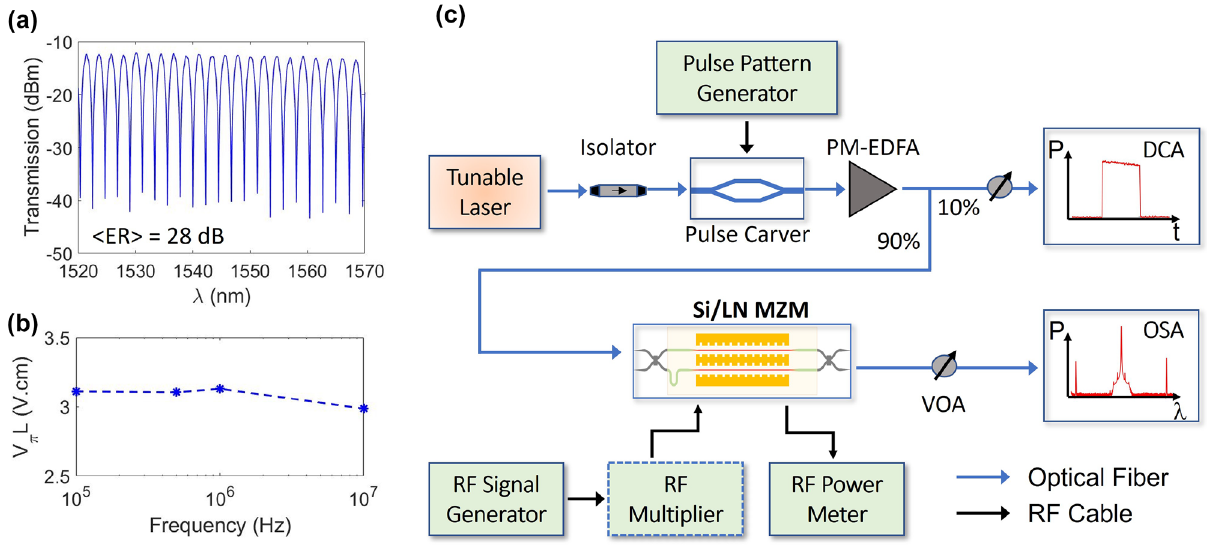
Figure 4. ( a ) The measured optical transmission of the asymmetric hybrid-bonded Si/LN MZM with no modulation signal applied. The asymmetric path-length difference gives an FSR of 2.3 nm, and an average ER of 28 dB over 50 nm. ( b ) The measured V π L of the hybrid MZM ( L ps = 0.5 cm) as a function of driving trapezoidal signal frequency. ( c ) A schematic block diagram of the quasi-CW high power electro-optic response measurement setup. Active RF multipliers were used for generating f > 50 GHz.